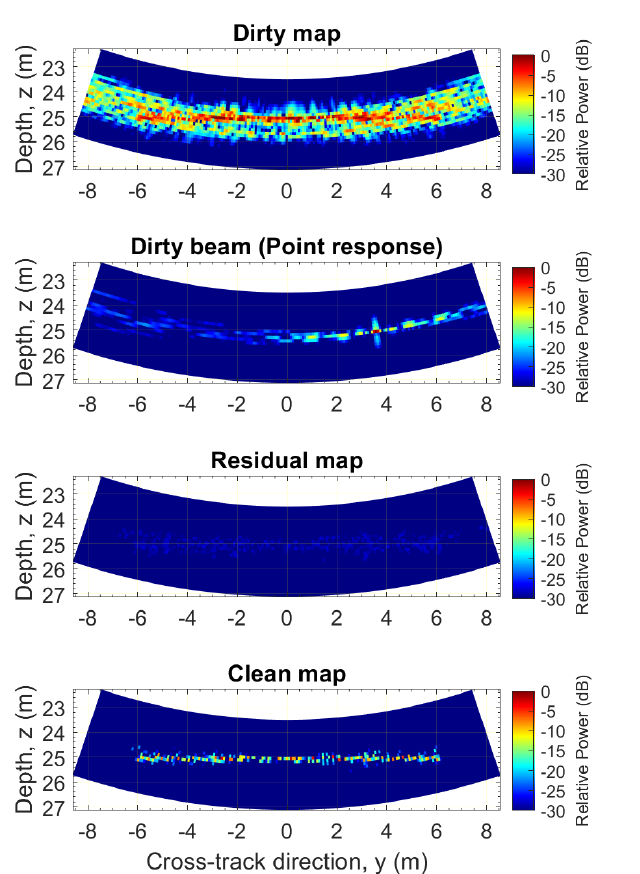
Figure A5. Example of a sidelobe-reduction algorithm for a simulated 1D Lambertian seafloor. The environmental and array configurations are the same as those in Figure A3. The estimated point source locations are well contained within the seafloor region, as shown by the final clean map after 1000